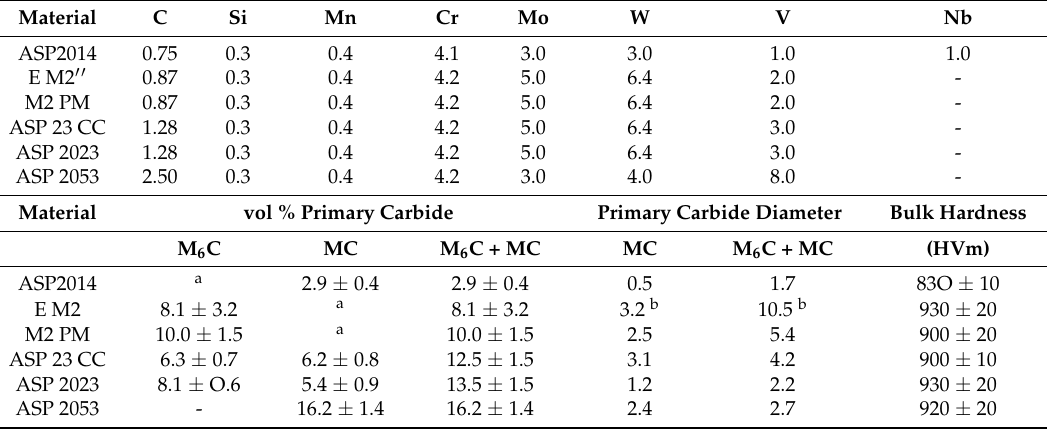
Table 2. Nominal chemical composition of the investigated materials (wt. %) and Microstructural constituents as vol % and average size of primary carbides ( µ m), and bulk hardness for the high speed steels (HSS’s) after ref.